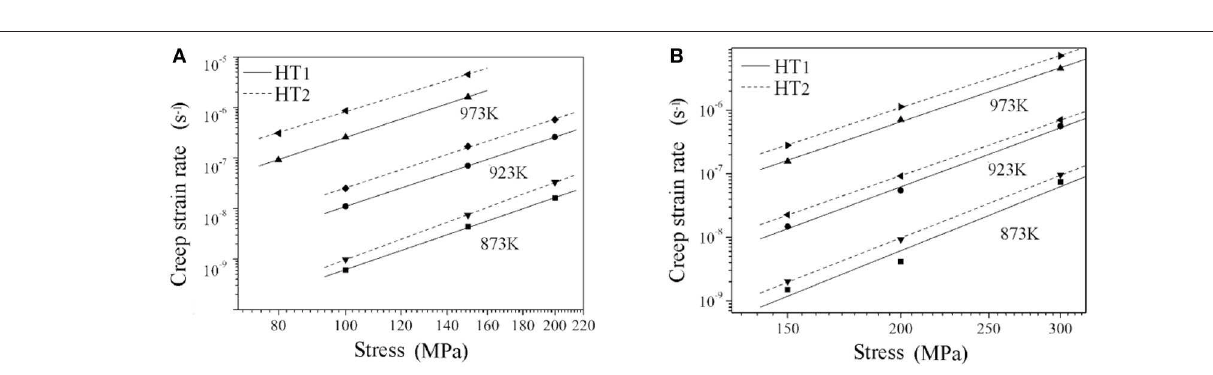
creep resistance decrease significantly, when oxidation content increases in Ti alloy (Pitt et al., 2004). The grain and α + β colonies size of HT2 sample are smaller than those of HT1.